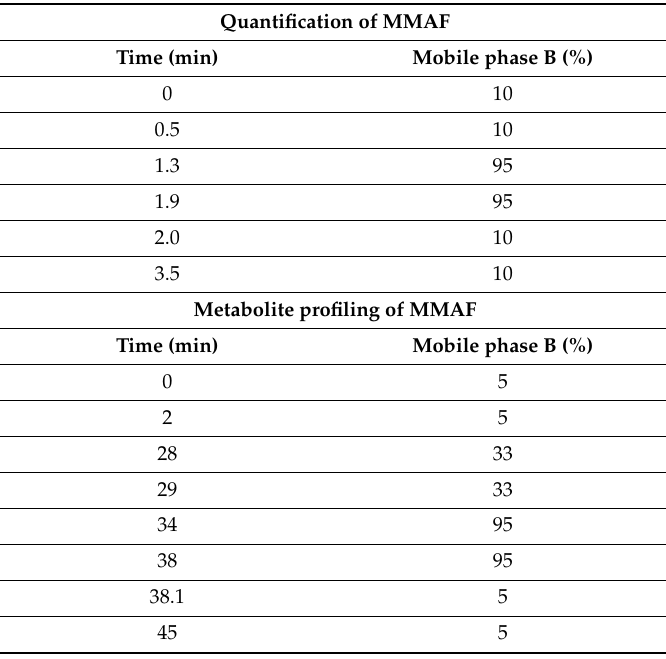
Table 1. Mobile phase conditions for LC